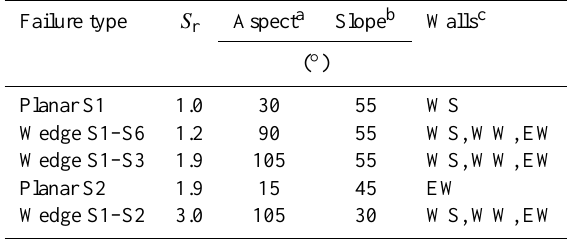
Table 2. Results of stability